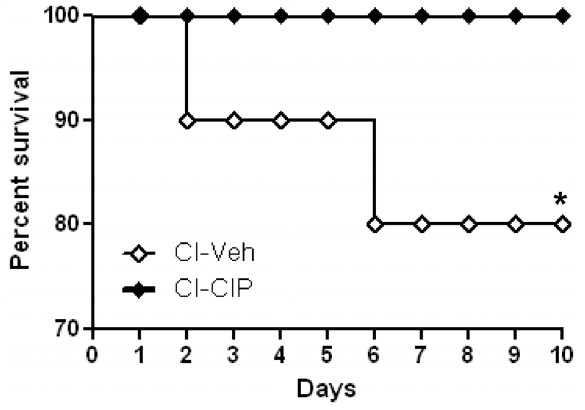
Figure 1. CIP improved survival after irradiation combined with skin-wound trauma (CI). Mice received 9.75 Gy 60 Co c -photon radiation followed within 1 h by 15% TBSA skin wound (CI). Mice were given CIP (90 mg/kg p.o. q.d. ) or vehicle for 11 days starting day 0 # 2 h after CI. Experiment was repeated to achieve statistical significance. n=10 per group, * p , 0.05 vs. CI + CIP. CI: combined injury;